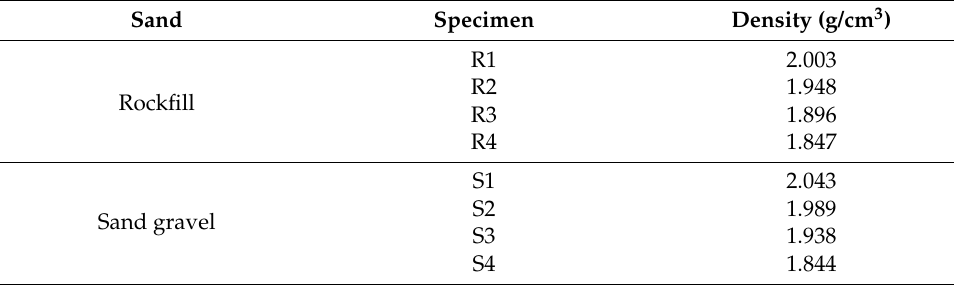
Table 1. Basic property of tested soil and specimens.